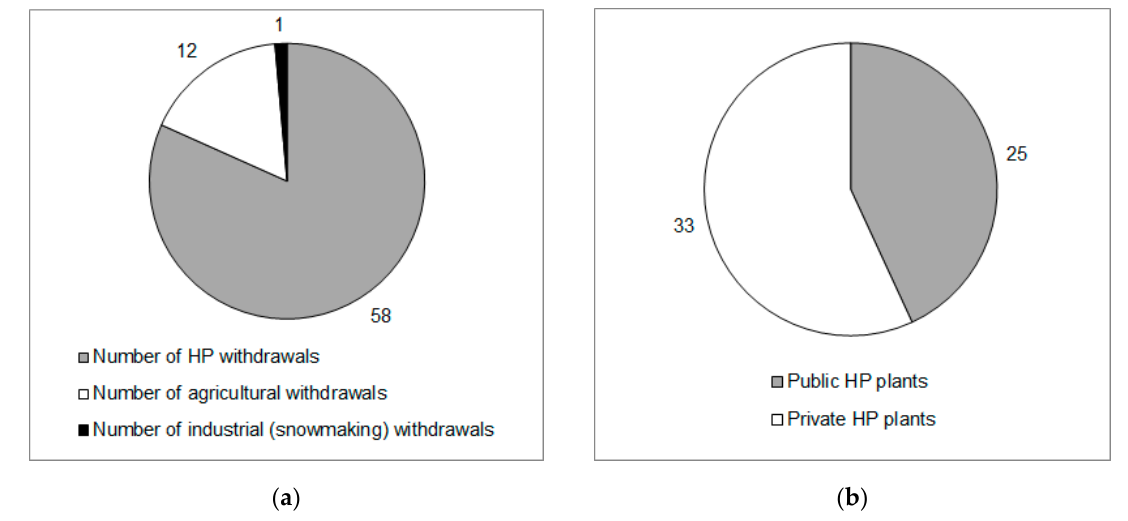
Figure 7. ( a ) Distribution of the different typologies of water withdrawals involved in the experimentations ongoing in Aosta Valley. ( b ) Number of public and private HP plants involved in the regional experimentations.